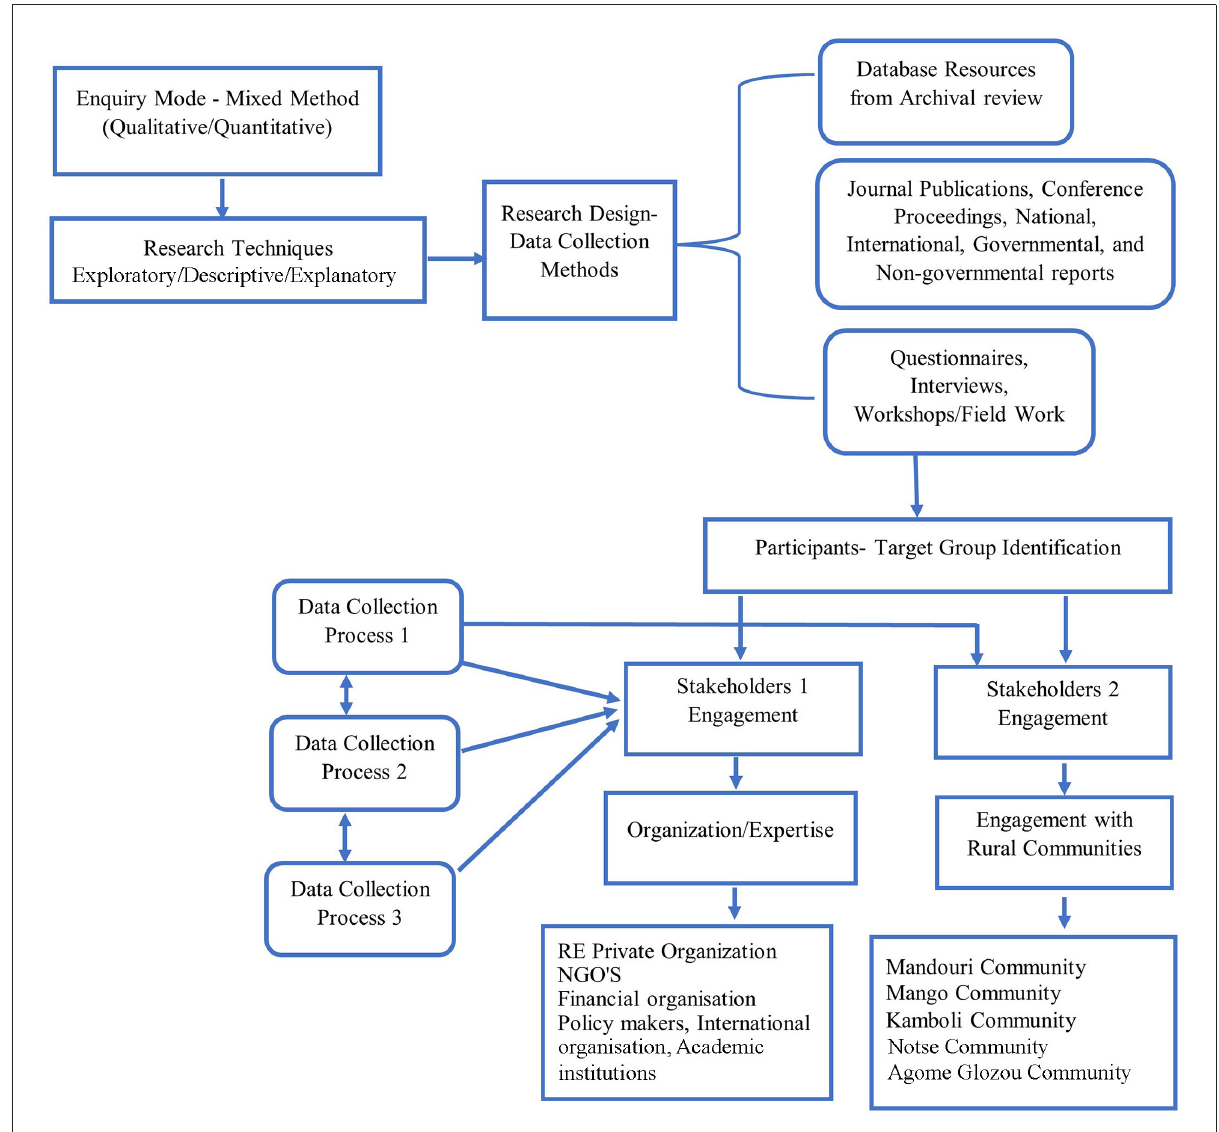
FIGURE1 Overview of the research approach conducted, the process, and included